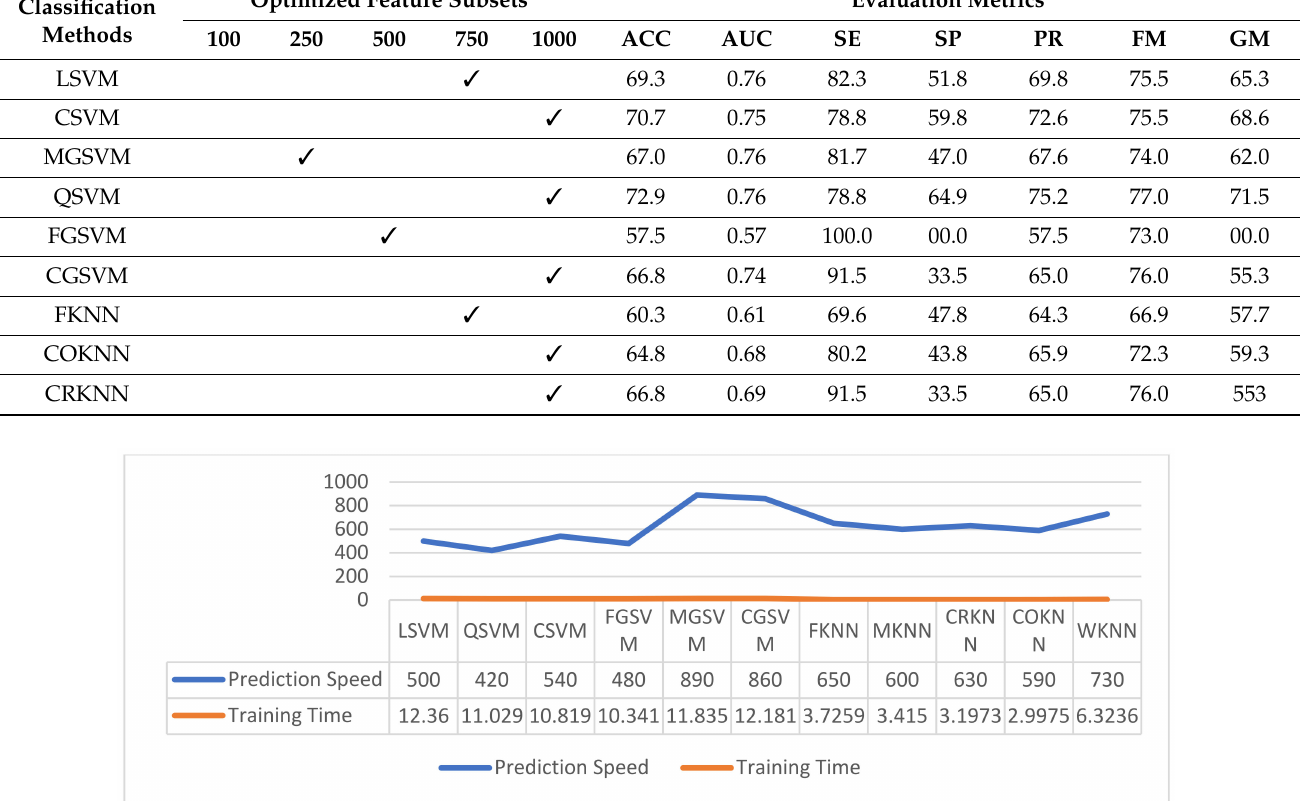
Figure 10. Proposed model training time (s) and prediction speed (obs/s) on front views of VIPeR dataset utilizing 1000-feature